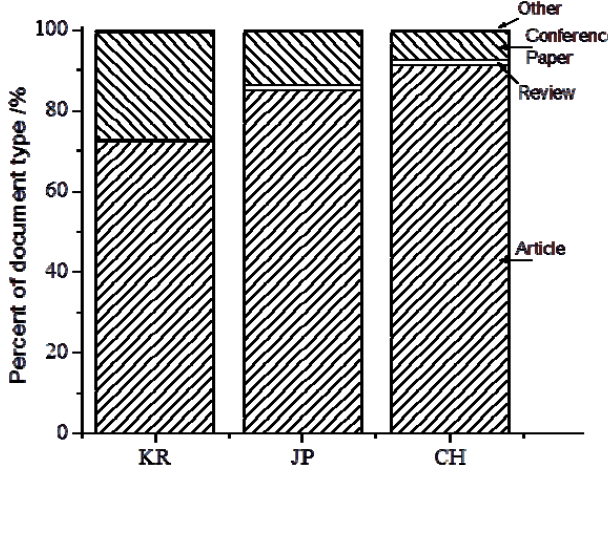
Figure 2. Proportions of publication sources produced in the field